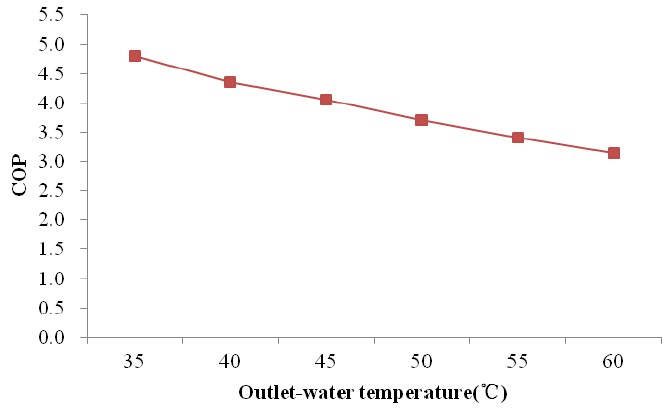
Figure 8. Variation in COP at an average temperature of 20 ◦ C for different outlet water temperatures.